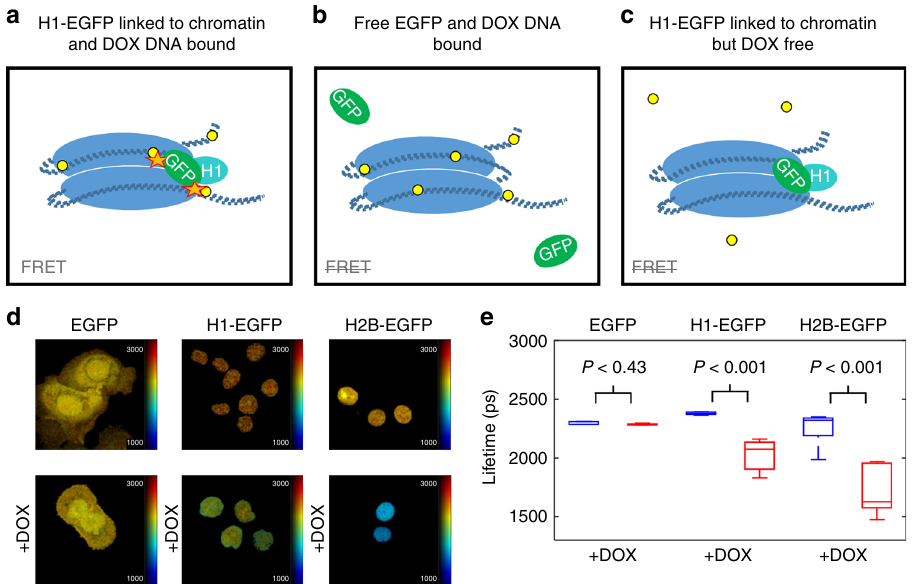
Fig. 2 In vitro fl uorescence lifetime measurement of doxorubicin binding to chromatin. a – c diagrams of possible interactions between doxorubicin and H1- EGFP chromatin. a doxorubicin (yellow dots) intercalation into DNA (blue regions represent the core histone optima and dark blue dashed lines represent DNA) brings it close to histone H1-EGFP, leading to energy transfer (orange stars). b GFP is not fused to histone H1 and is therefore not suf fi ciently close to DNA bound doxorubicin for energy transfer to occur. c doxorubicin is not binding DNA and therefore no energy transfer with histone H1-EGFP occurs.